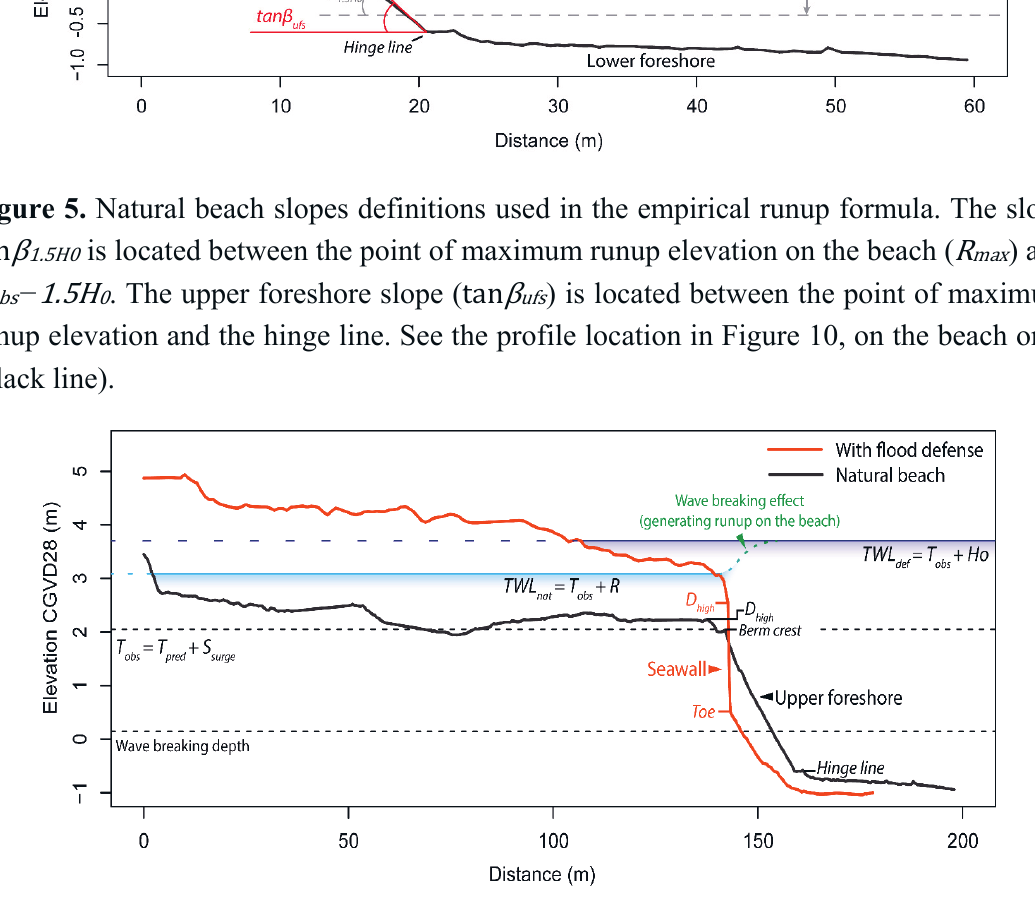
Figure 6. Sketch of the morphological difference between the defended (red) and natural (black) coastline. Modelled TWL are shown for both the natural beach (light blue) and defended coastline (dark blue). Profile locations are shown in Figure